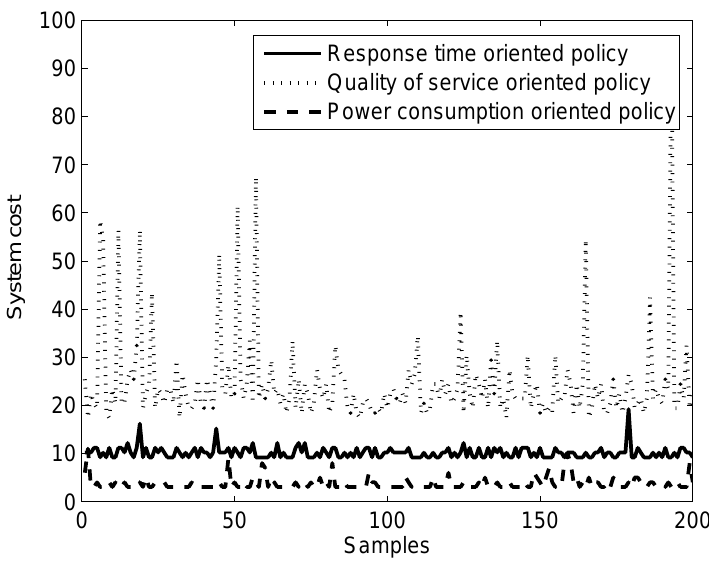
Figure 25. Comparison of system cost.